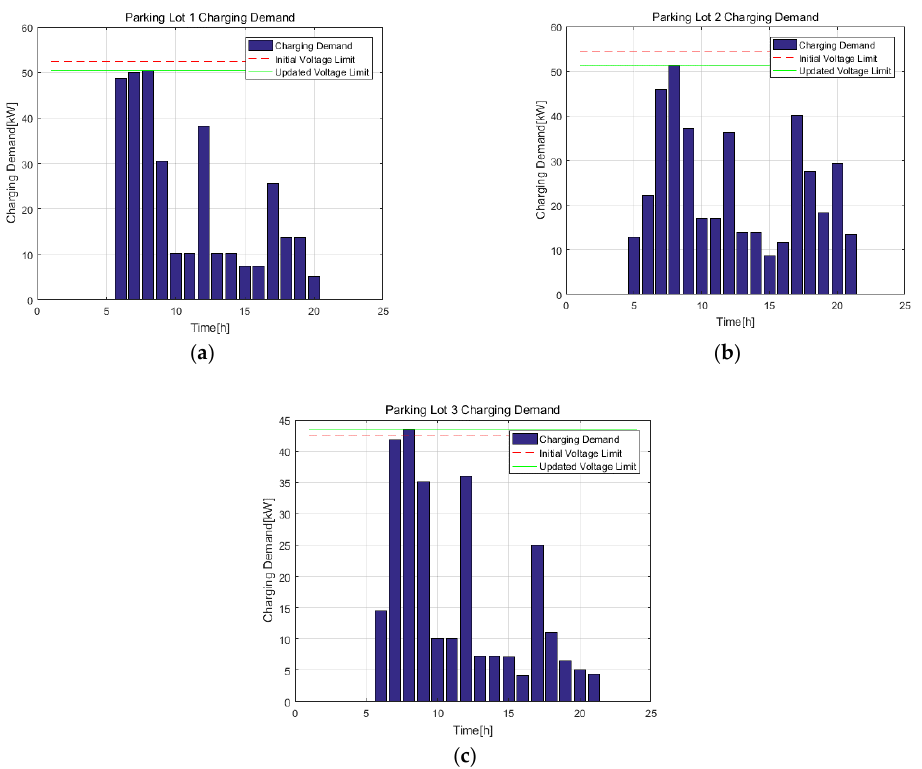
Figure 13. Integrated Charging Load of Parking Lot with MPC ( a ) PL1, ( b ) PL2, ( c ) PL3.